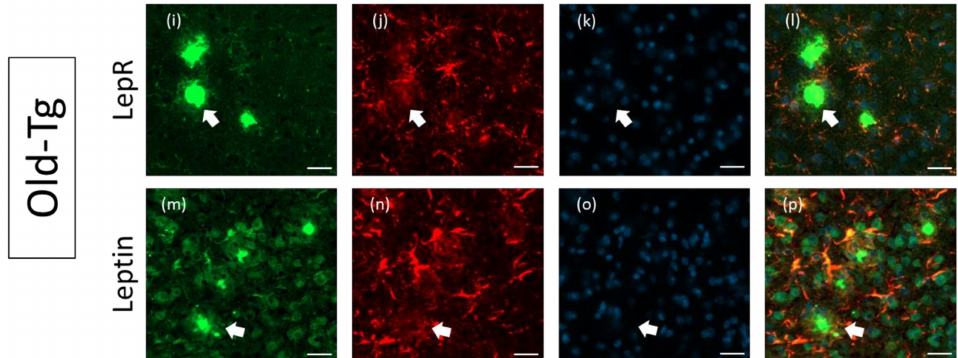
Figure 4. Astrocytic expression of leptin and LepR in the cerebral cortex of young (10–12 week) and old- (48–52 week) 5XFAD (Tg) mice. Thioflavin- S -stained amyloid plaques (arrows) are present in the cerebral cortex of old-Tg and to a lesser extent in young-Tg mice. LepR and leptin was detected in neurons and astrocytes in the cerebral cortex of young- ( a and e , respectively) and old-Tg ( i and m , respectively) mice. Panels ( b , f , j , n ) depict astrocytes labelled with GFAP. Panels ( c , g , k , o ) depict nuclei staining with DAPI. Colocalization of LepR with GFAP ( l ) and leptin with GFAP ( p ) labelled astrocytes of old-Tg mice was observed. Co-expression of LepR ( d ) and leptin ( h ) with GFAP was also observed to a lesser extent in young-Tg mice. Scale bar = 20 µ m.